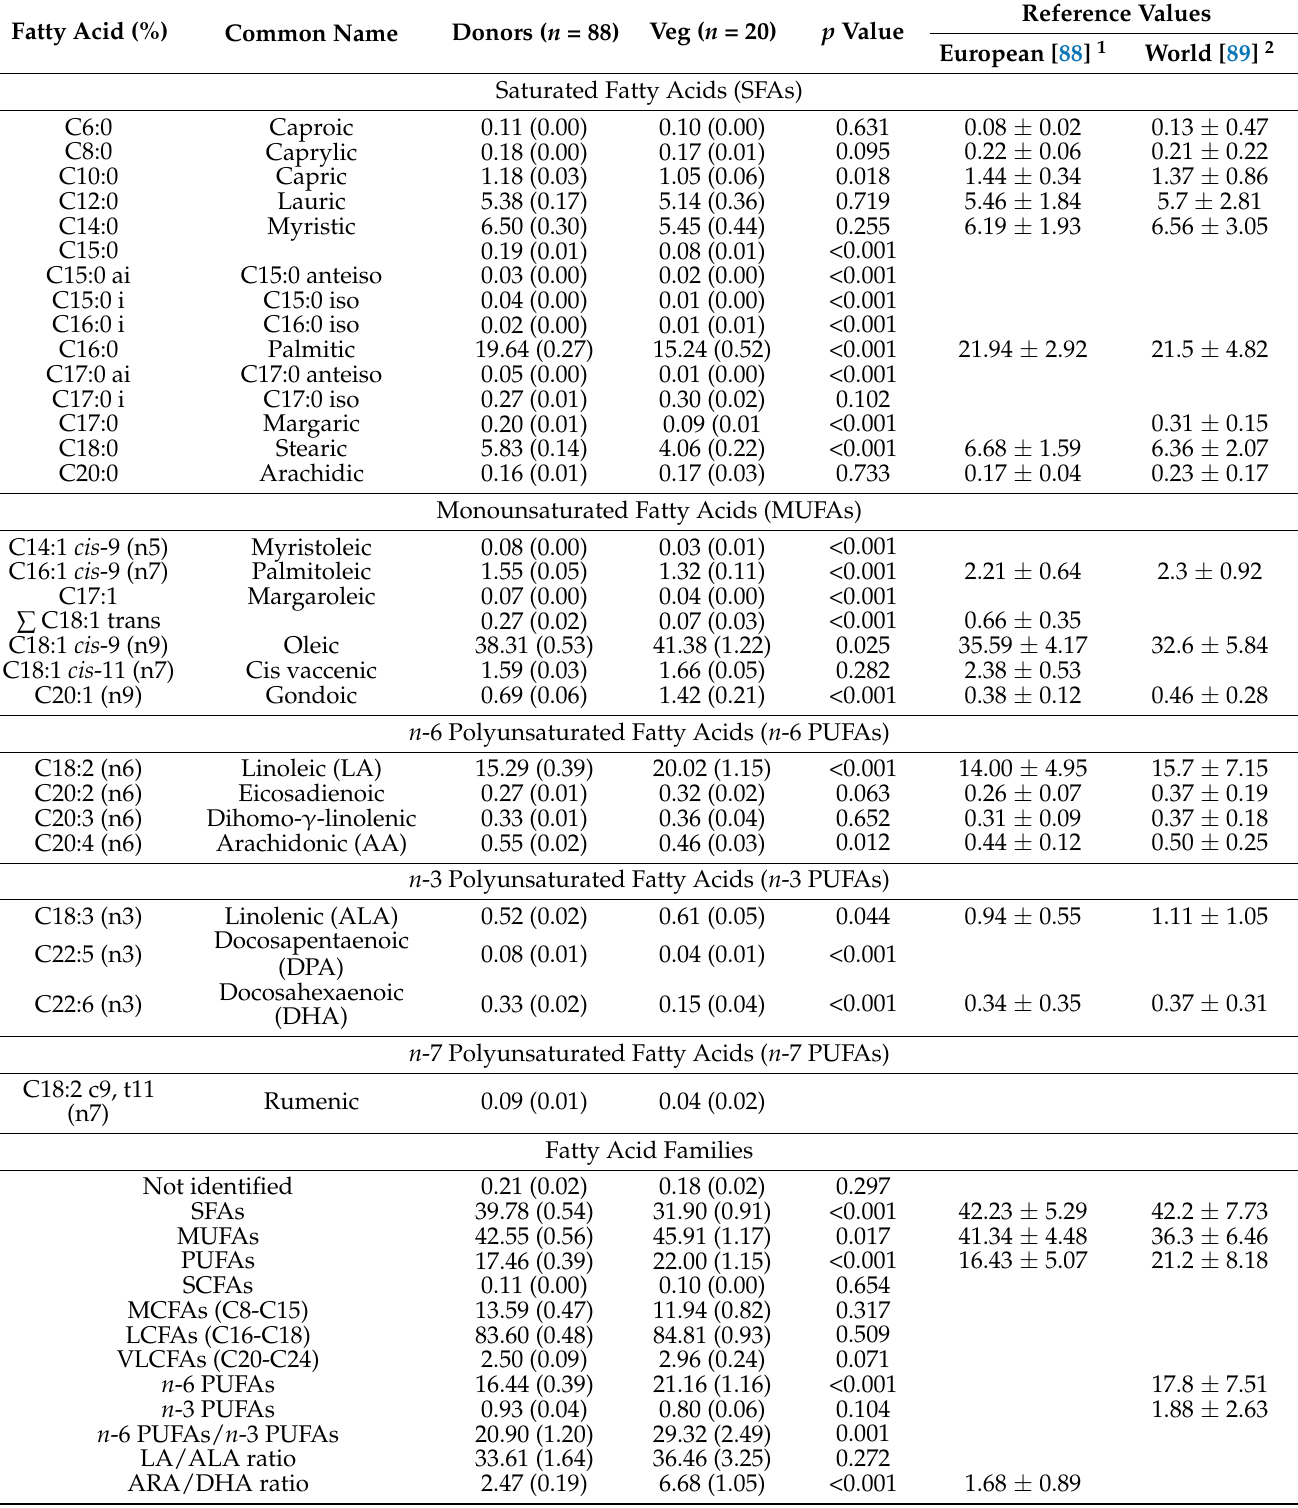
Table 12. Human milk fatty acid methyl esters (FAMEs) composition (g/100 g of total fat) of the omnivore human milk donors with full-term infants (Donors) and vegetarian/vegan mothers